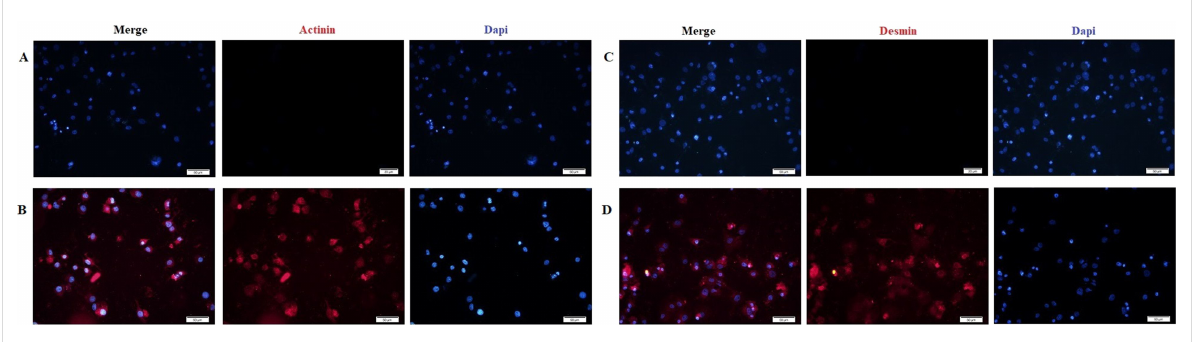
Figure 3: BM-MSCs differentiate into the cardiac lineage in vitro. A and C are negative controls (BM-MSCs cells in the absence of cardiac differentia- tion culture medium); (B) actinin (red)-positive and (D) desmin (red)-positive cells expressed in the cardiomyogenically differentiated BM-MSCs; nuclei were stained by DAPI in